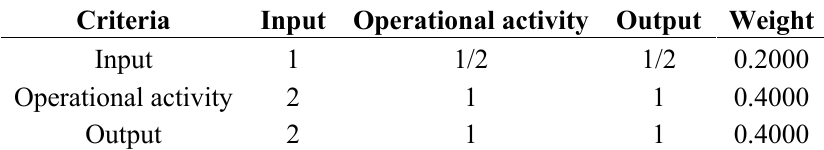
Table A1. The pair-wise comparison matrix for criteria.